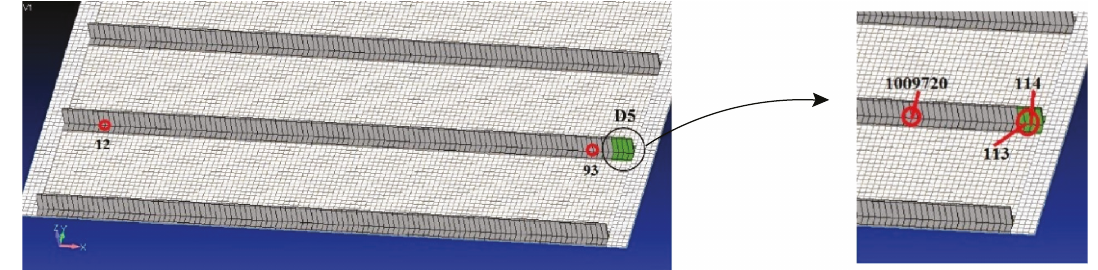
Figure 19: Excitation and measuring nodes for D5 damage along the second sti ff ener.